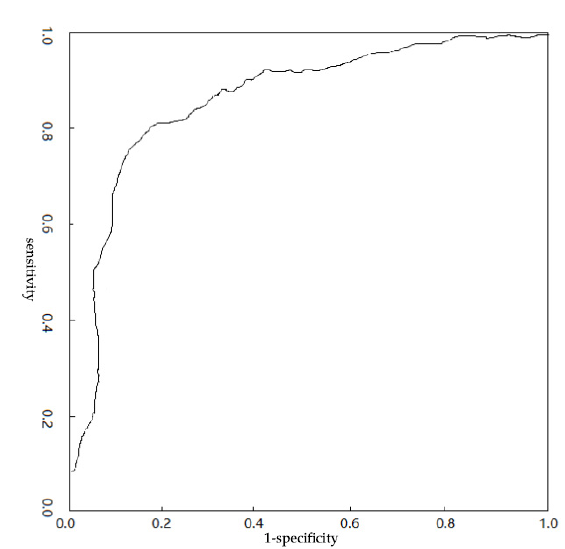
Figure 6. SVM-CSDPC disease prediction model ROC curve.